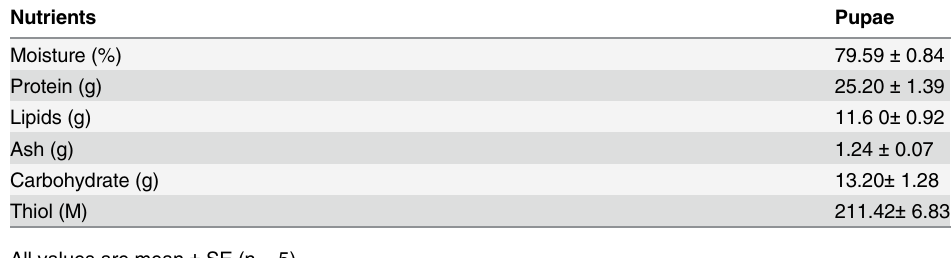
Table 1. Proximate composition of nutritional value in Vespa affinis L. values were expressed per 100 g of pupae. Nutrients